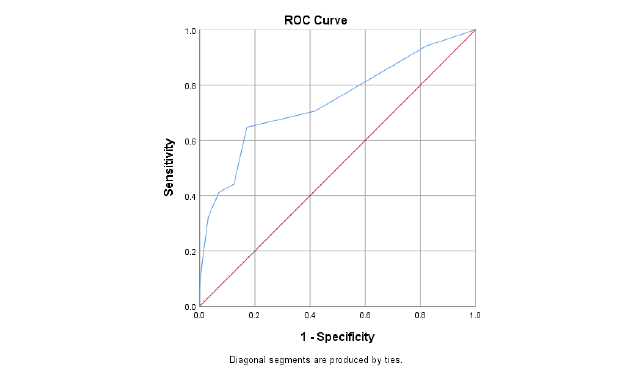
Fig. 1. Receiver Operating Characteristic (ROC) curve and Area Under the Curve (AUC) for prediction of intra-operative outcome based on preoperative scores. Table 5: Predictive association of risk factors with intraoperative